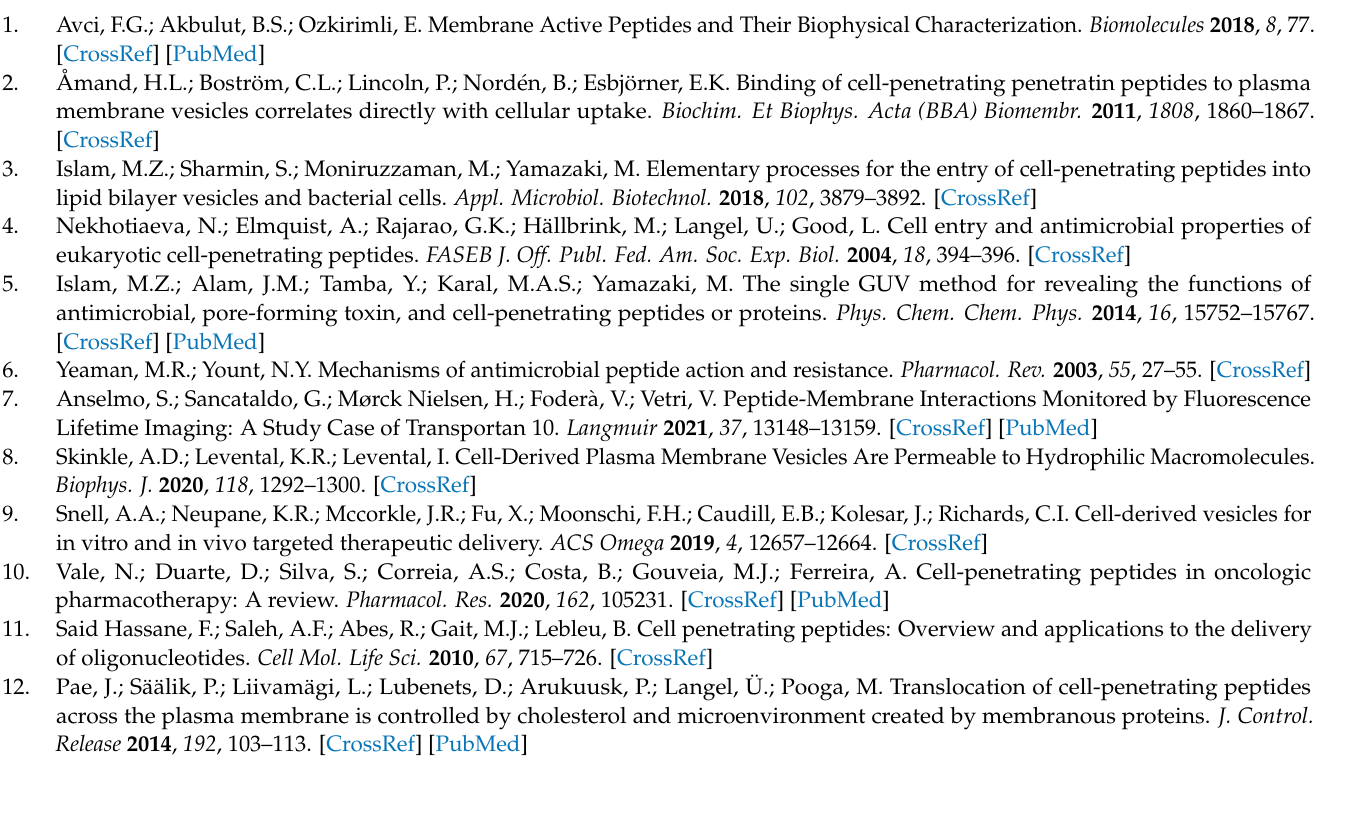
ulation buffer” addition, Figure S2: FLIM measurements from CF-TP10 1 h after the addition to GPMVs, Figure S3: FLIM measurements from NR-stained GPMVs in the presence of lower TP10 con- centration, Figure S4: FLIM measurements from NR-labeled GPMVs morphologically modified with the action of TP10, Figure S5: Intensity maps of FLIM measurements from di-4-ANEPPDHHQ-labeled